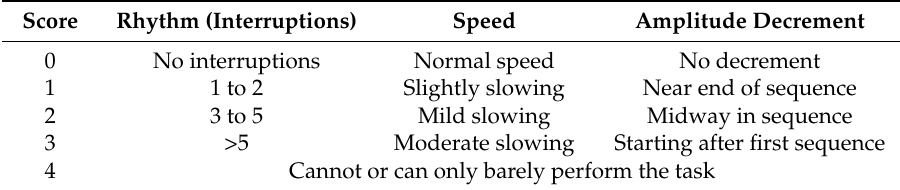
Table 2. Definition of task 3.6 “Pronation-Supination Movements of Hands”